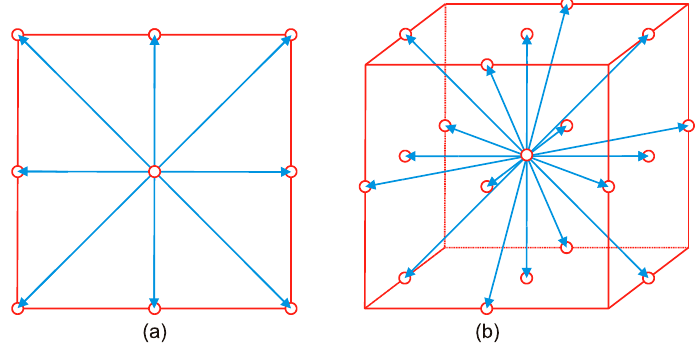
Figure 1. Two typical lattices often used in LB simulations: ( a ) D2Q9; and ( b ) D3Q19.